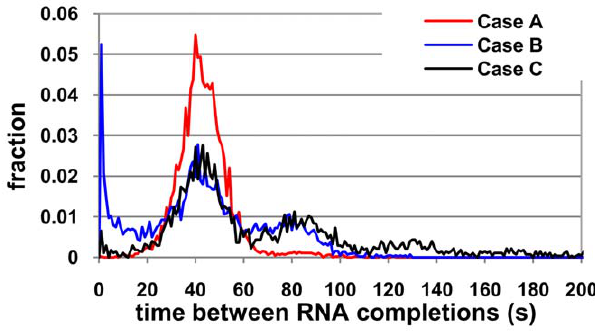
Figure 9. Effects of a sequence-specific long-duration pause. Time interval between the completion of consecutive RNA molecules in a gene with 400 nucleotides in case (A) without long-duration pause sites, case (B) with one long-pause site at nucleotide 200 where k pause is half the value of the rate of stepwise elongation and d pause is 1 min, and case (C), identical to case (B) but with a 20% chance that a long-paused RNAP will lead to premature termination.